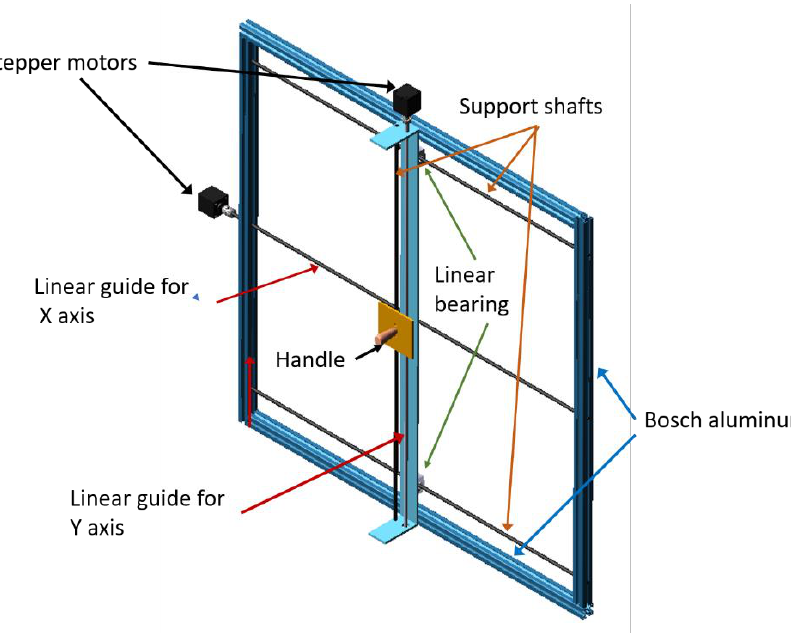
Figure 5. Shoulder rehabilitation machine.